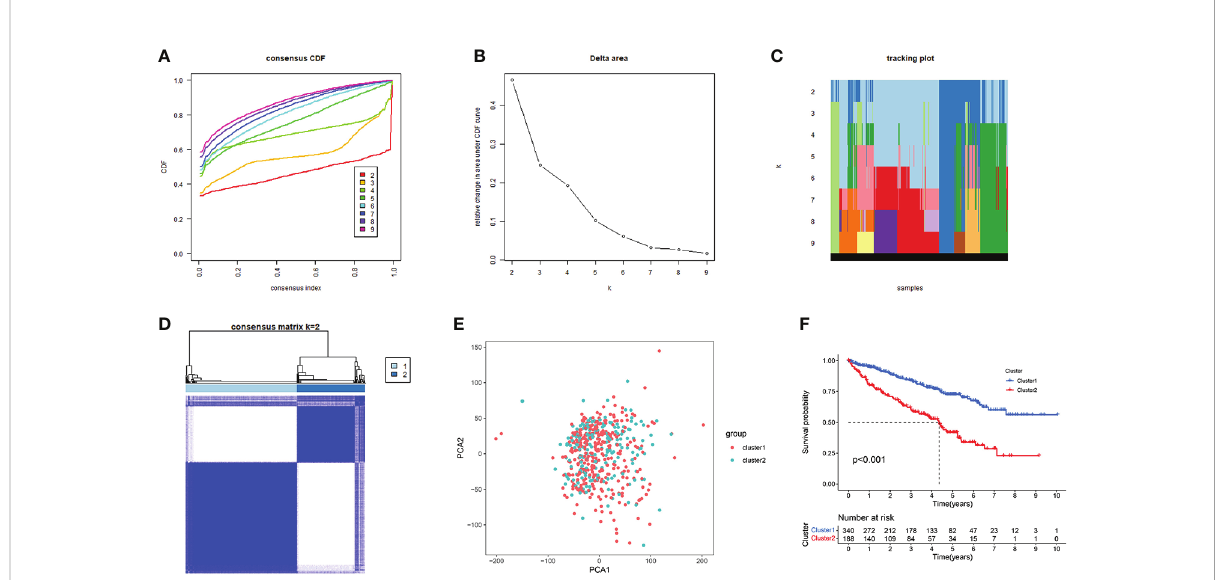
FIGURE 4 Consensus clusters by 23 AAG-related lncRNAs. (A) Consensus clustering cumulative distribution function (CDF) for k = 2 to 9. (B) Relative change in area under the CDF curve for k = 2 to 9. (C) Tracking plot for k = 2 to 9. (D) Consensus clustering matrix for k = 2. (E) Principal component analysis of the gene expression pro fi les. (F) Kaplan – Meier curve showing a different prognosis between the two